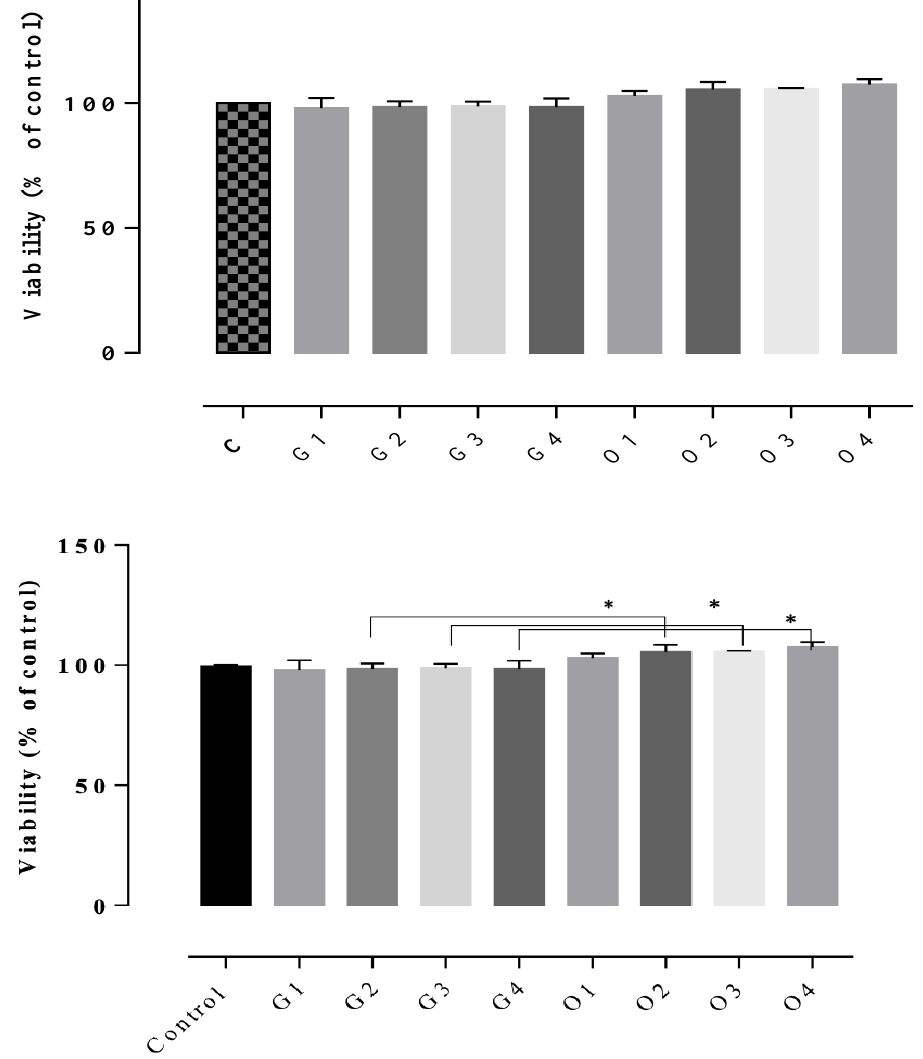
Figure 7. D1MSCs cells viability assessment after treatment with control gel and gel with Oregano ® essential oil, where Control = D1MSCs cells in normal propagation medium; G1, 2, 3, 4 = the gel without essential oil in 4 different concentrations (2.4; 4.7; 7 and 9% ( v / v )); O = the gel with Oregano ® essential oil in 4 different concentrations of gels (2.4; 4.7; 7 and 9% ( v / v )), * p < 0.05.